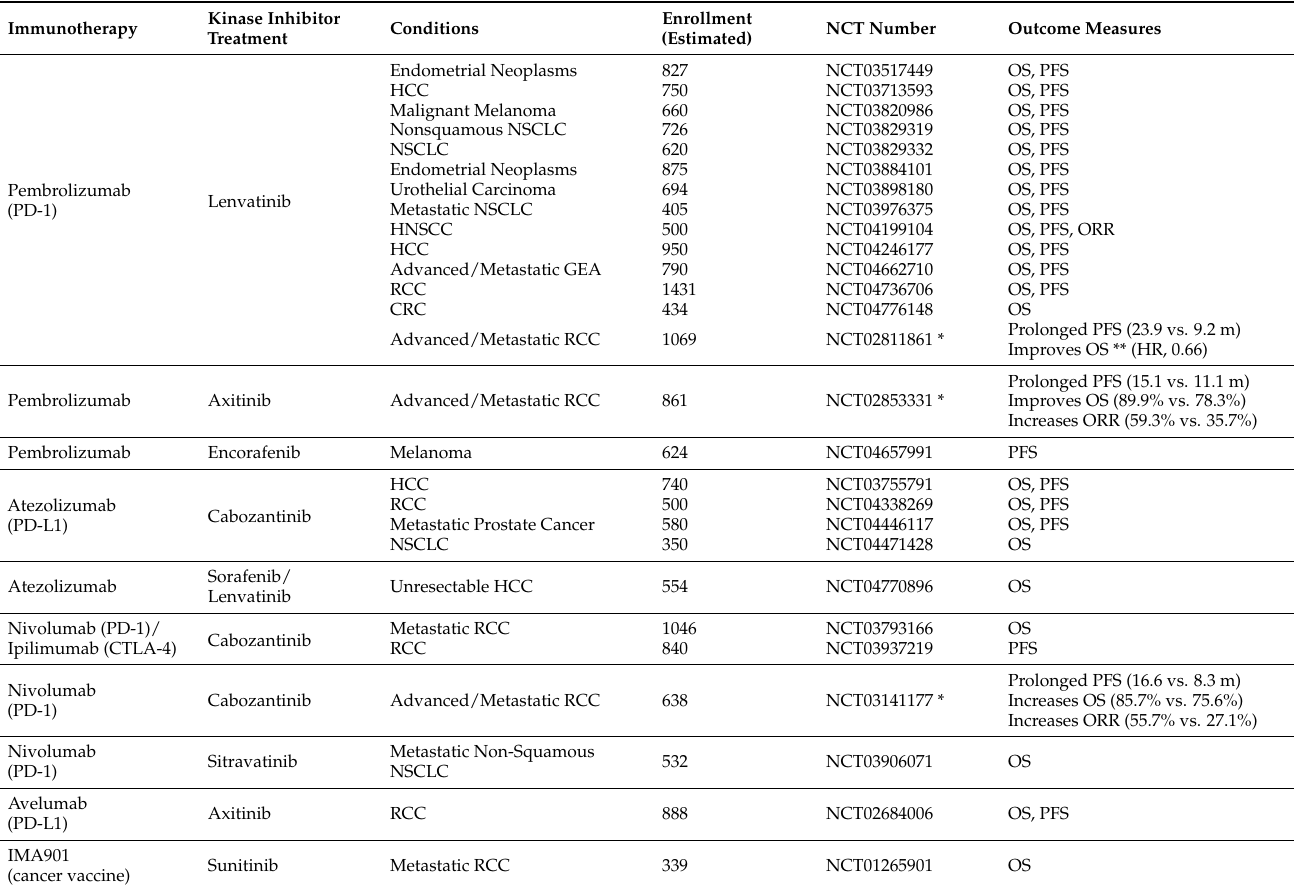
Table 3. Ongoing/completed phase 3 clinical trials of kinase inhibitors combined with immunotherapies in treatment of solid